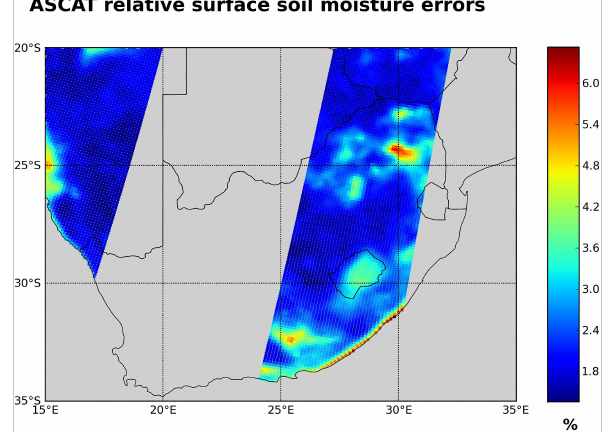
Fig. 17. Maps of R 2 computed for the block mean (0.25 ◦ ) filtered ASCAT soil moisture as SWI and closest (in time) block mean TOP- KAPI SSI. These values were obtained from calculations like those in Fig. 16.